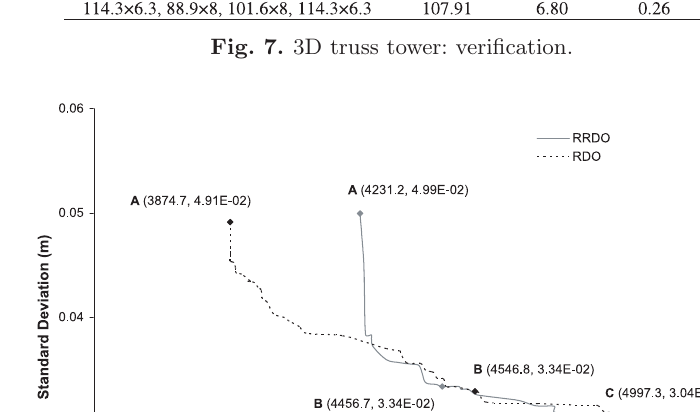
Fig. 7. 3D truss tower: verification.